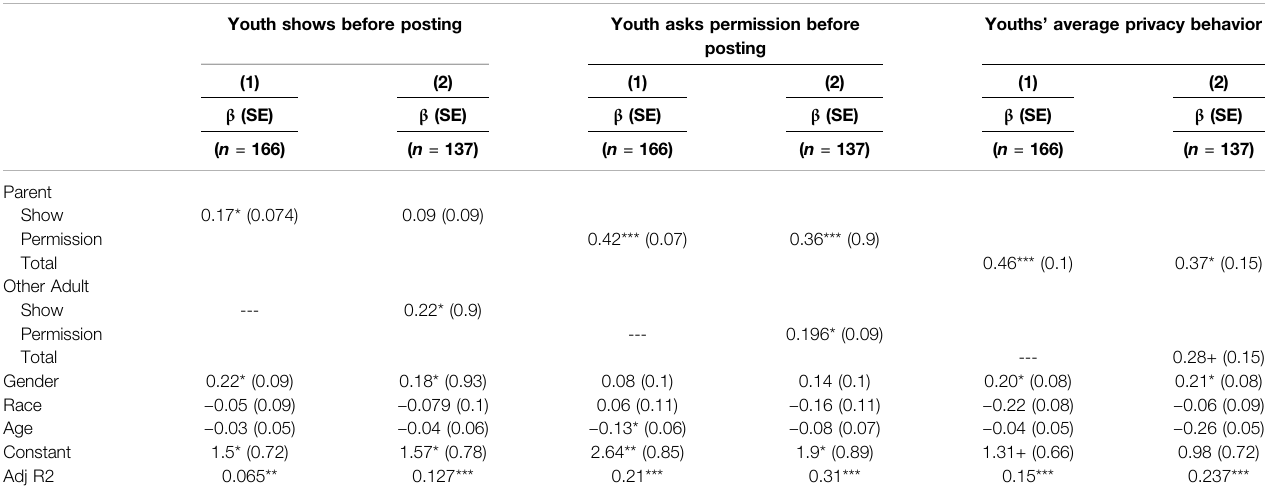
TABLE 3 | OLS Regression testing if parent and other adults ’ behaviors predict youths ’ posting